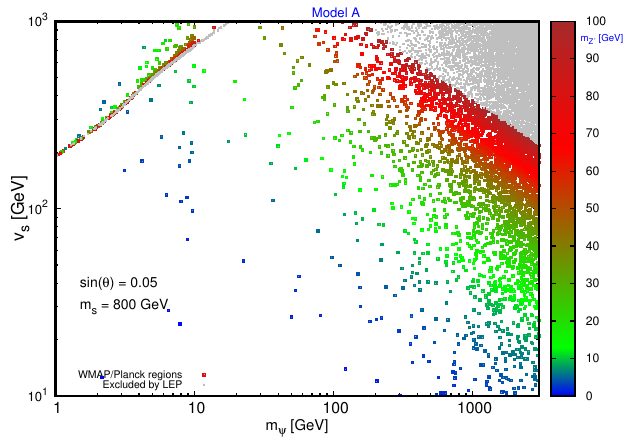
Figure 4 . Same scan for model A as in (cid:12)gure 3 except that the ( g (cid:0) 2) (cid:22) constraint on model A is